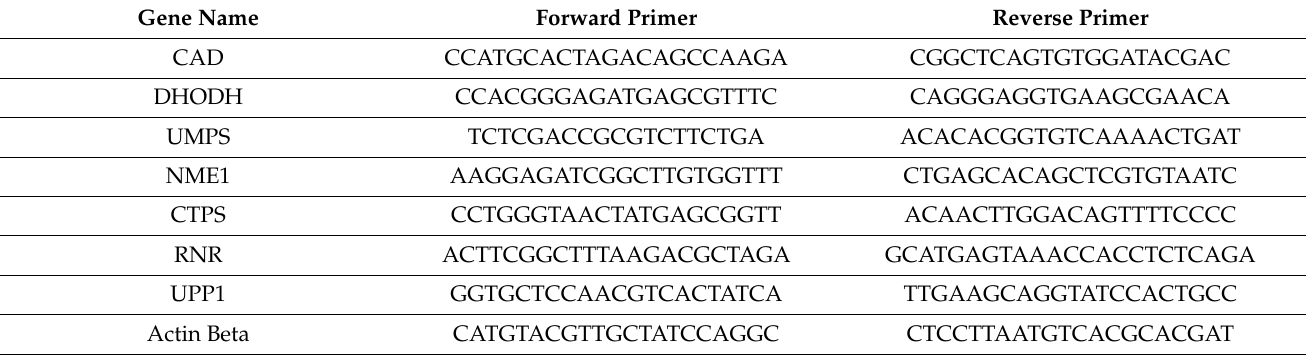
Table 1. Primers for